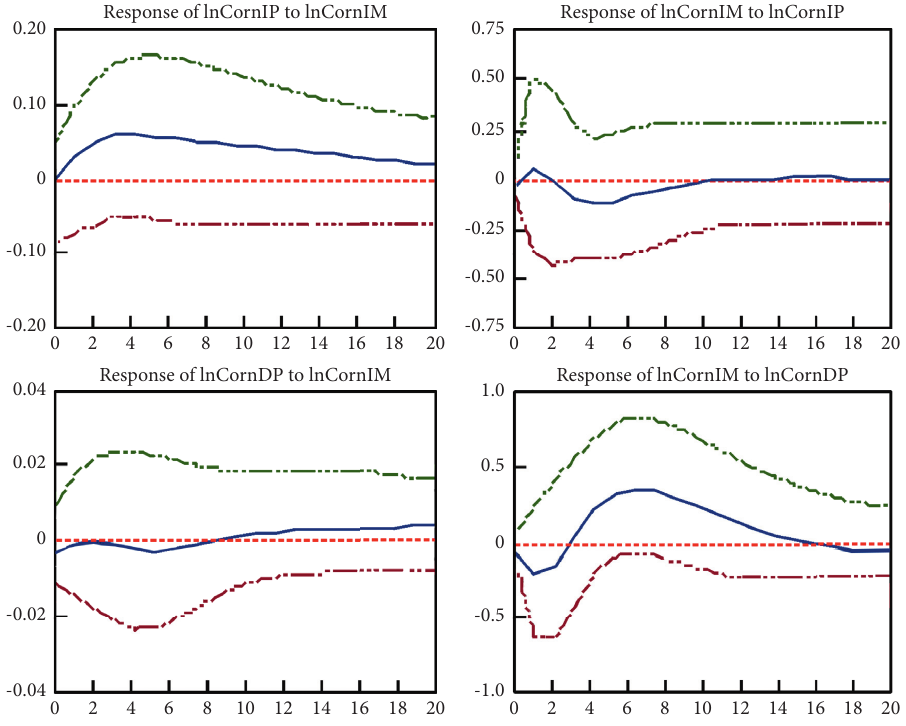
Figure 7: Pulse response analysis results for